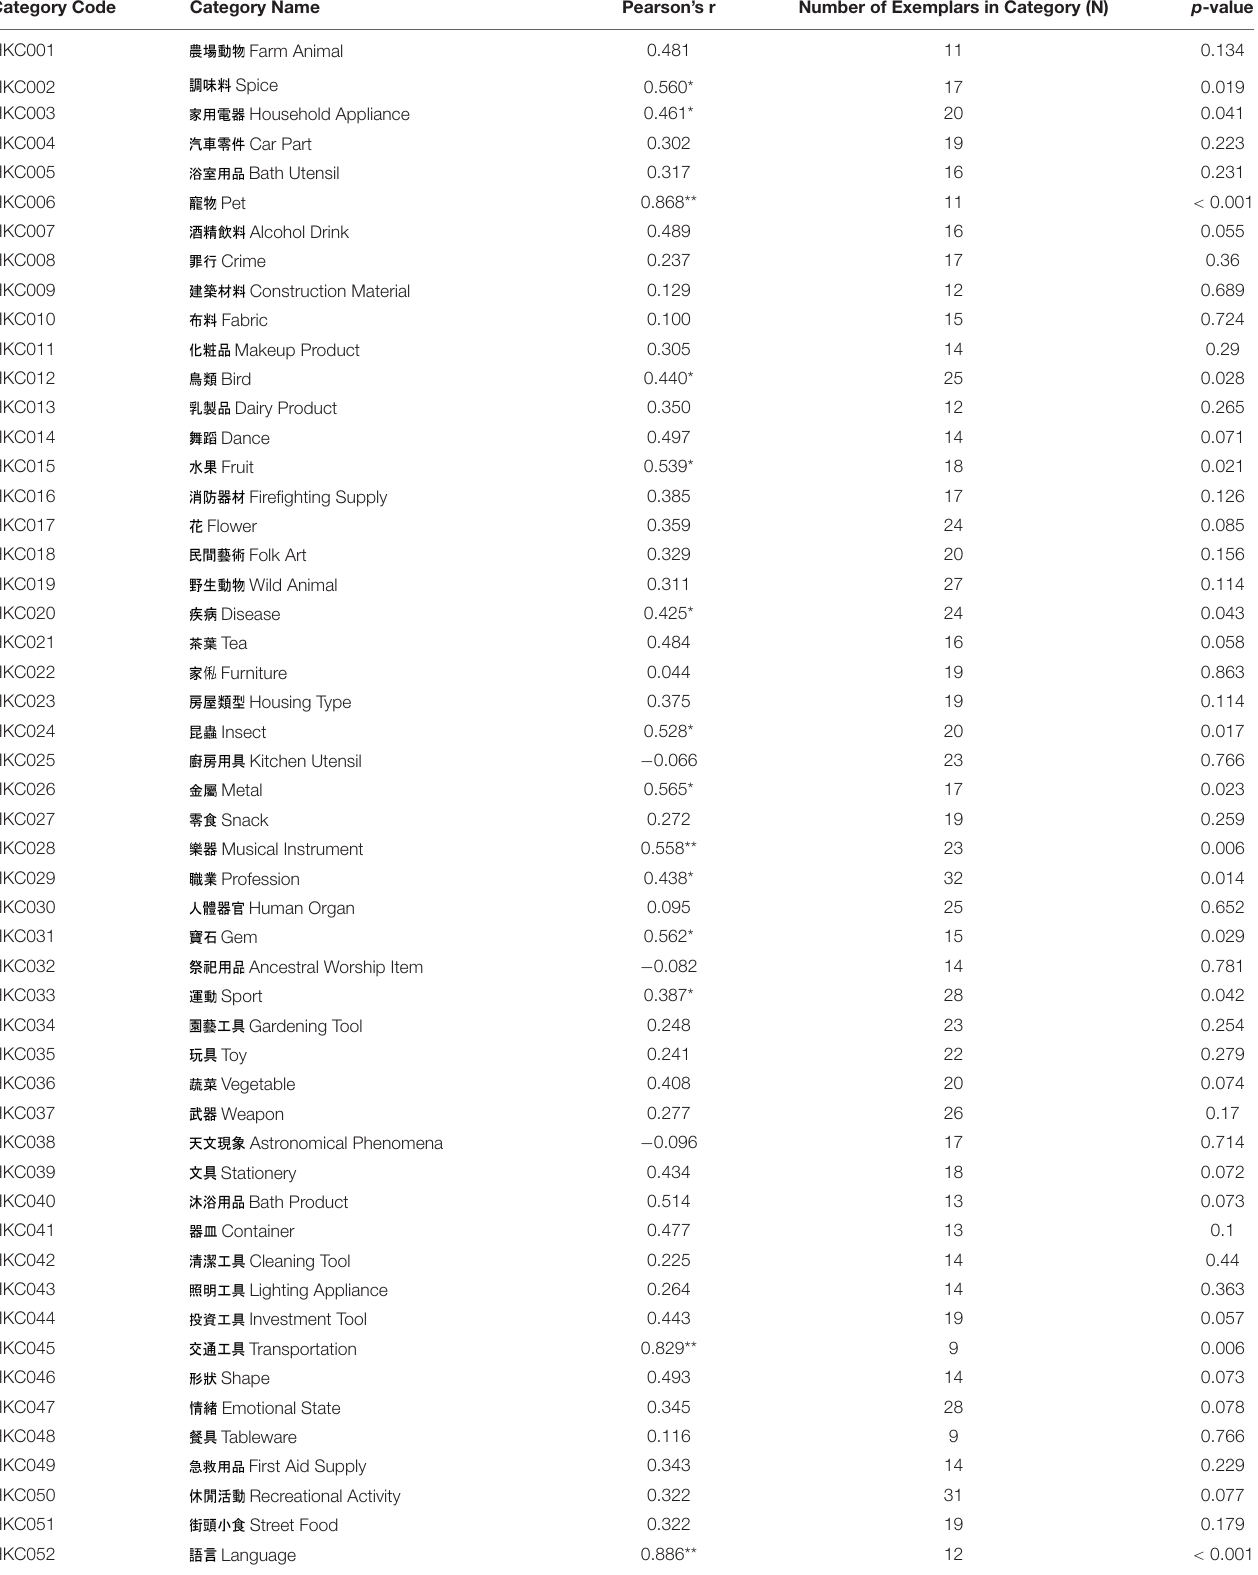
TABLE 3 | Correlations between total (the probability of being recalled, indexing typicality) and familiarity of exemplars, for each